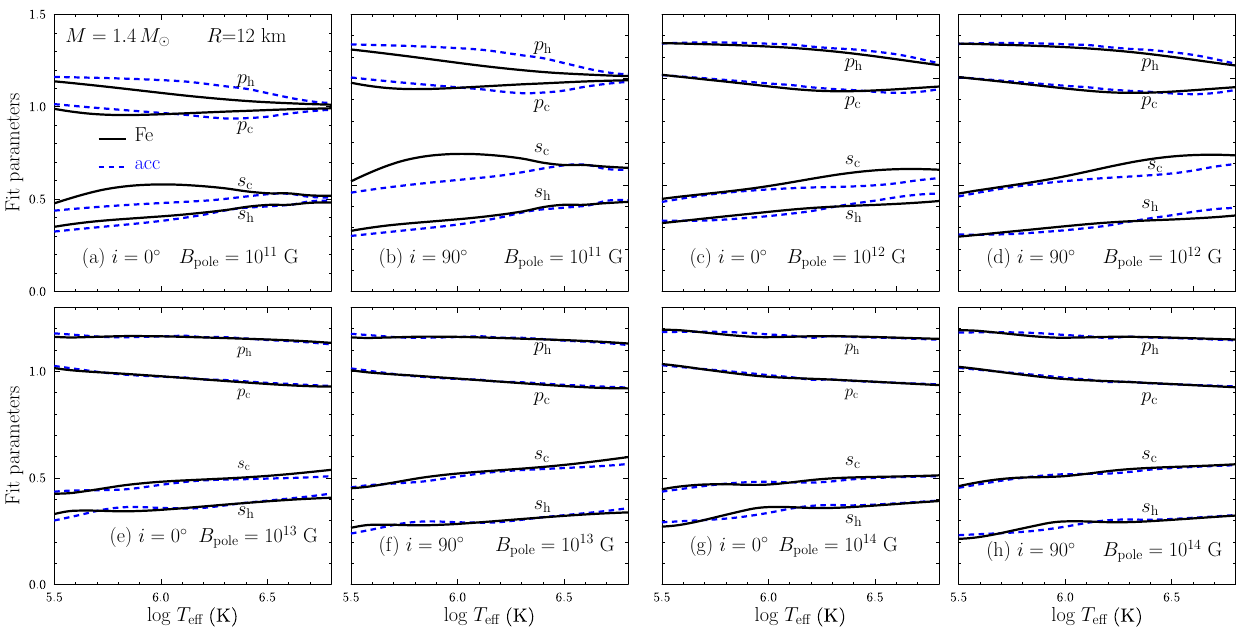
Figure 5. The 2BB fit parameters versus log T eff for a 1.4 M 10 14 G [panels ( a – h )] for polar ( i = 0) and equator ( i = 90 ◦ ) observations. Solid lines refer to the star with iron heat blanket, while dashed ones are for accreted heat